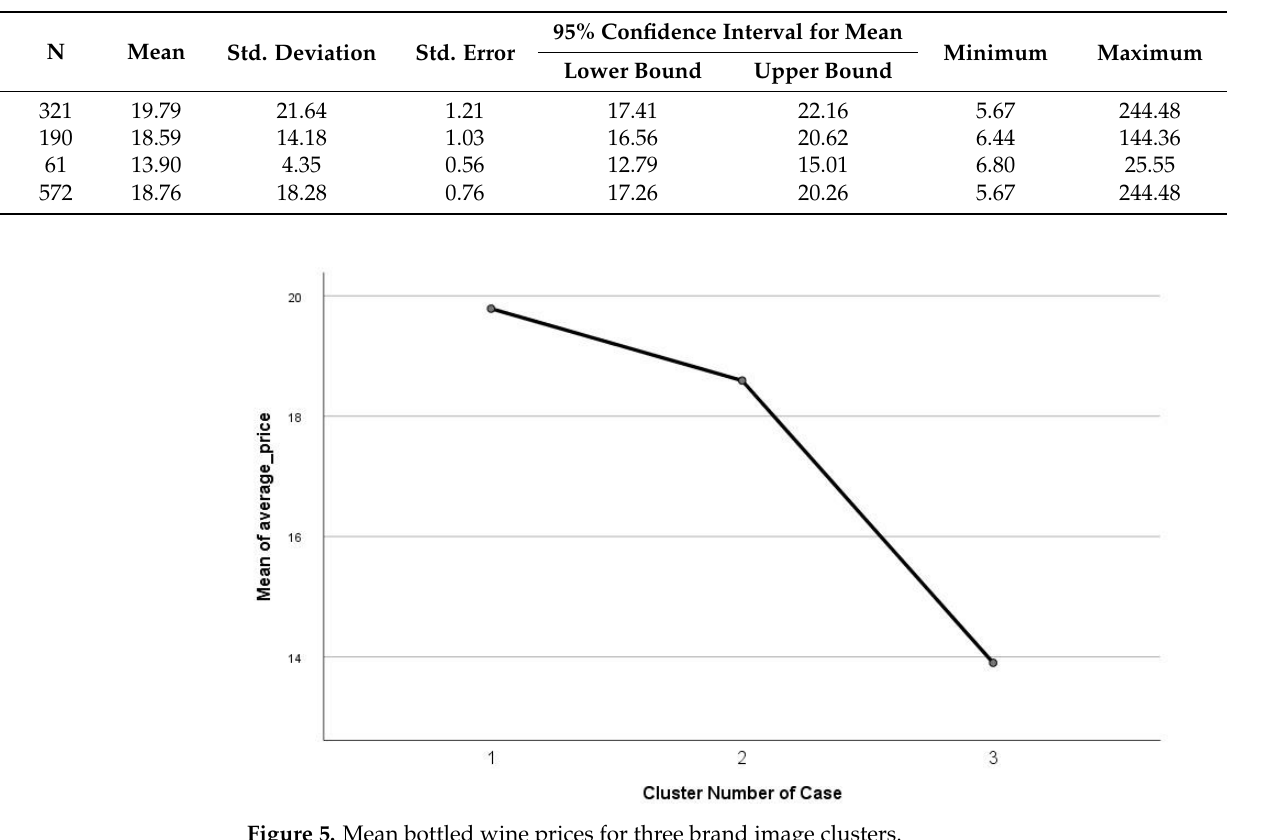
Table 8. Mean bottled wine prices for three brand image clusters.